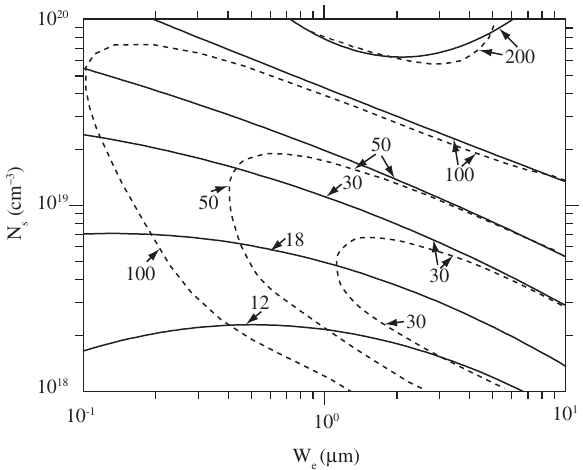
Figure 6. Short-circuit current density contour plots, J tion of surface doping concentration, N solar cell with base resistivity 1 Ω